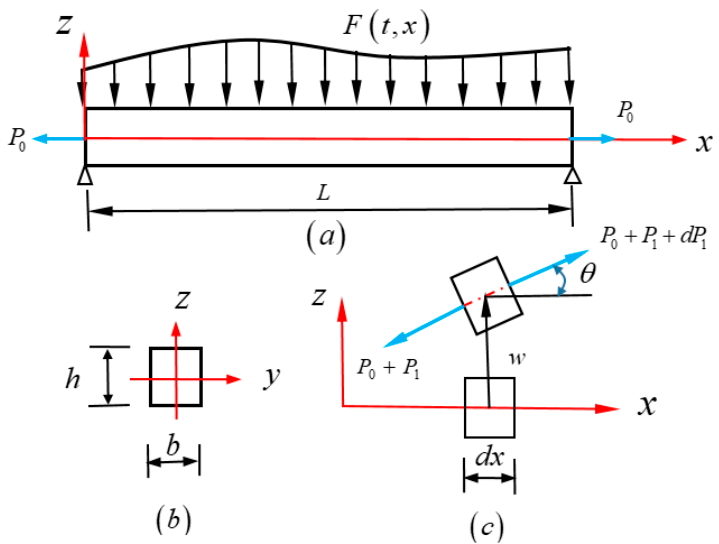
Figure 1. Portrait of the structure: ( a ) The undeformed coordinate system, ( b ) cross-section, ( c ) the displacement and rotation